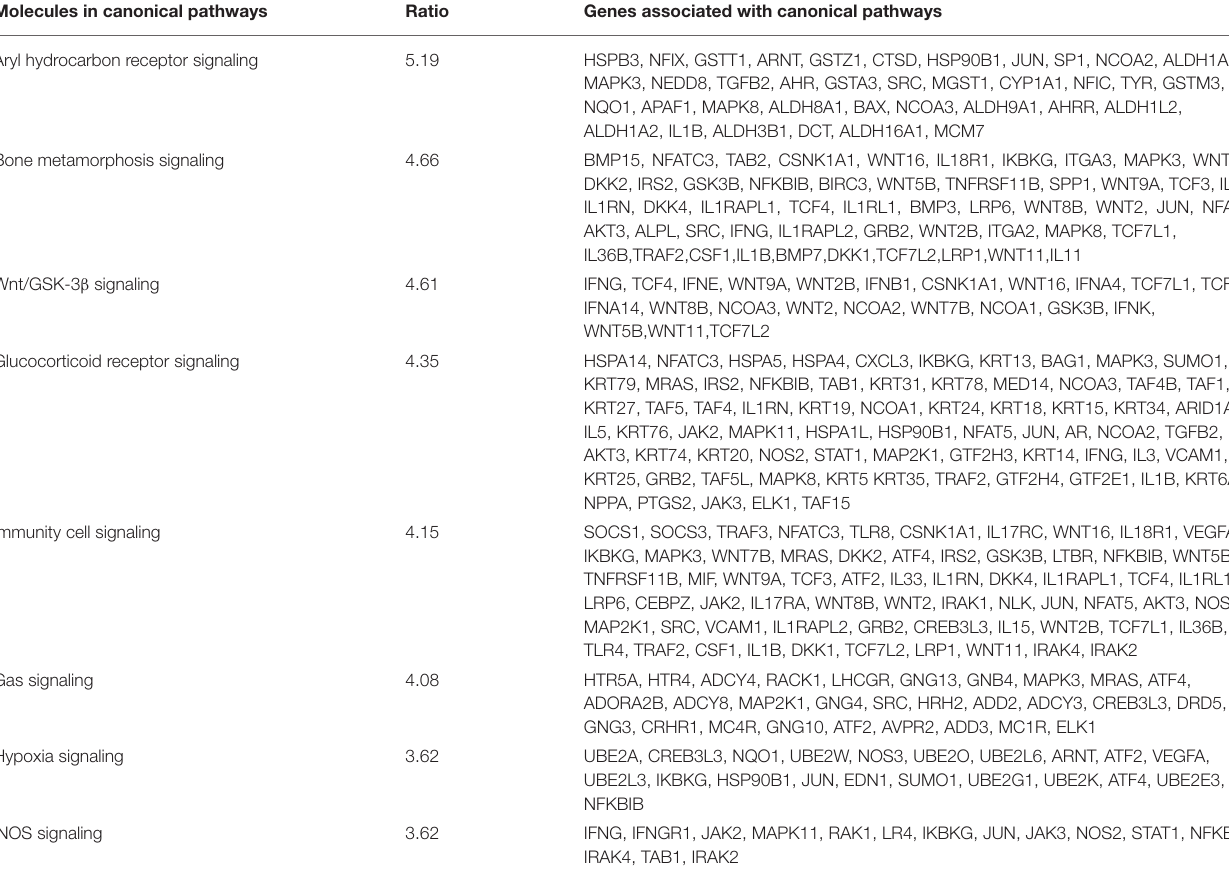
TABLE 3 | Genes associated with canonical pathways and network in prostate cancer. Molecules in canonical pathways Ratio Genes associated with canonical